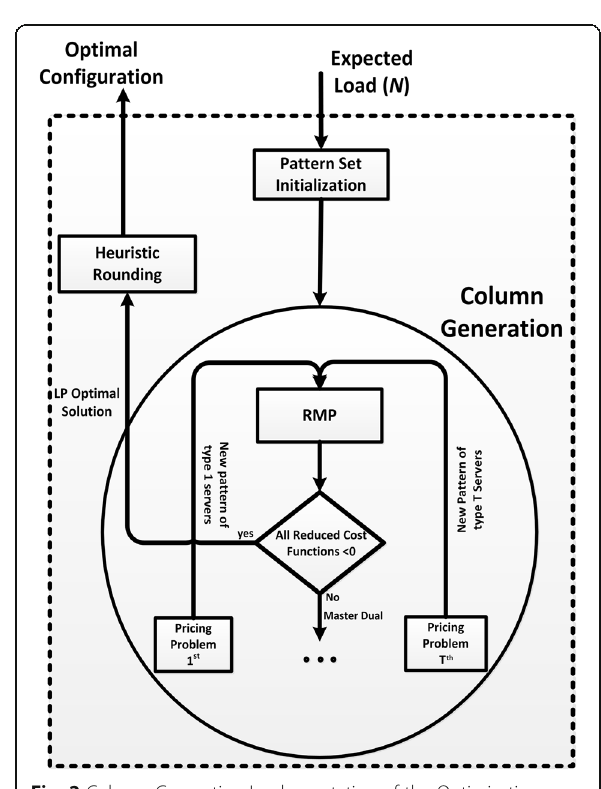
Fig. 2 Column Generation Implementation of the